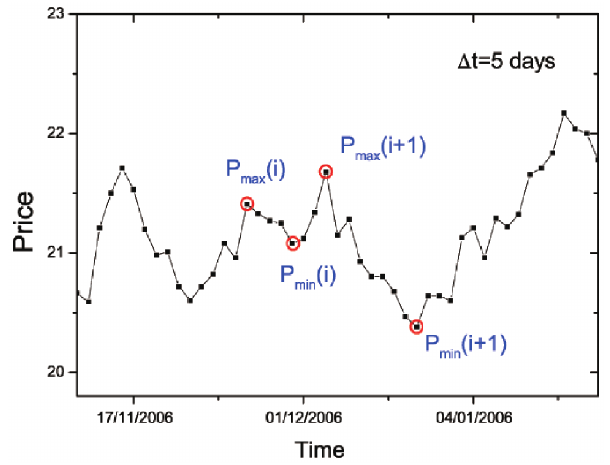
Figure 1. Schematic graph showing the breakout and break- down. Square symbols denote the daily closing price versus time, for one component stock of S&P500 Index ranged from November 11, 2006 to January 22, 2007. P max ( i ) and P max ( i + 1) are the local maxima in the time interval [ t – D t , t + D t ] and P min ( i ) is the local minimum between the two adjacent local maxima. Here D t =5 days. The line is a guide to the eye.